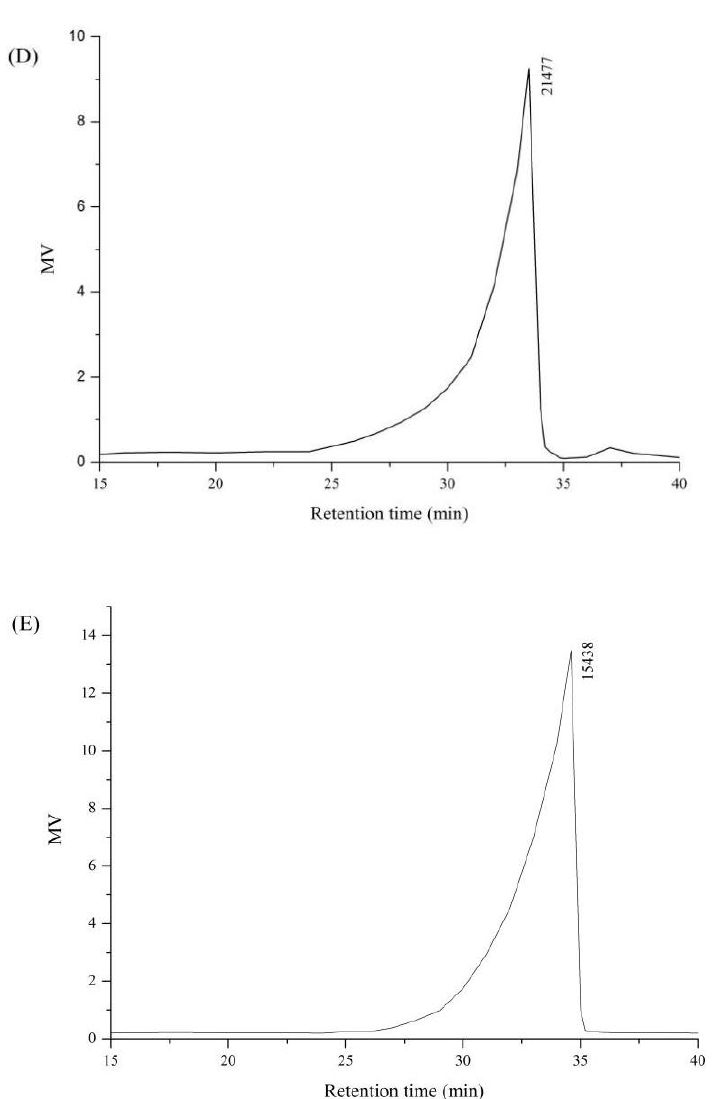
Figure 1. Elution profiles of Jasminum sambac flower polysaccharides (JSPs) on Diethylaminoethyl 52 (DEAE-52) cellulose and Sephadex G-100 column. ( A ) Crude JSP elution profile on DEAE-52 cellulose column; ( B ) elution profile of JSP-1 on Sephadex G-100 column; ( C ) elution profile of JSP-2 on Sephadex G-100 column; ( D ) high performance gel permeation chromatography (HPGPC) chromatogram of JSP-1; ( E ) HPGPC chromatogram of JSP-2.